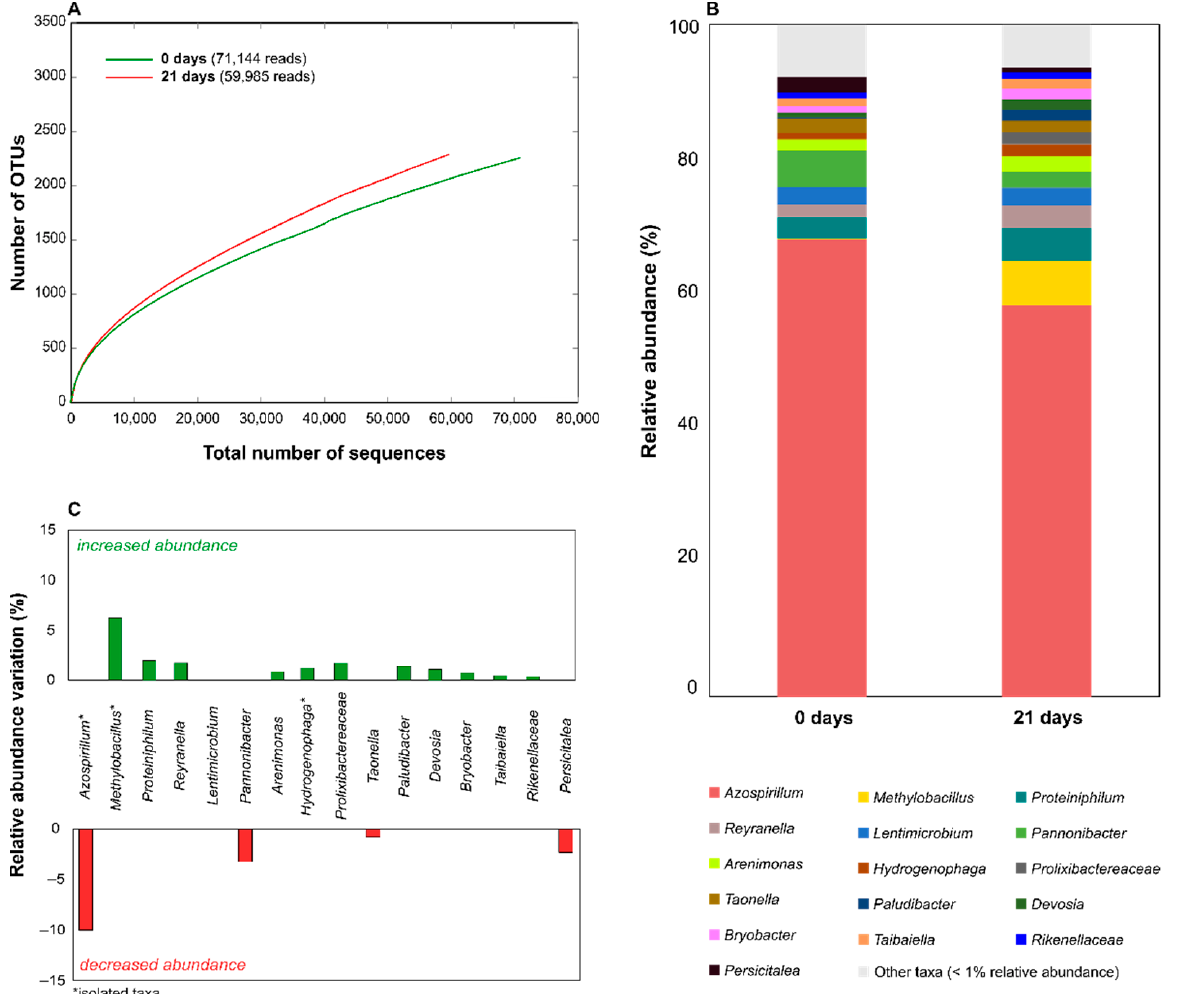
Figure 4. 16S rRNA amplicon sequencing data for the EPO-enriched consortium at the beginning and at the end of a 21-day incubation period with 5 mg.L − 1 of EPO. Figure panels show the alpha rarefaction curves (panel A ), the bacterial consortium structure at the family or genus levels (panel B ), and the relative abundance variations observed during the 21-day incubation period with EPO (panel C ). The number of amplicon reads obtained for each bacterial taxa is shown in Table S1.